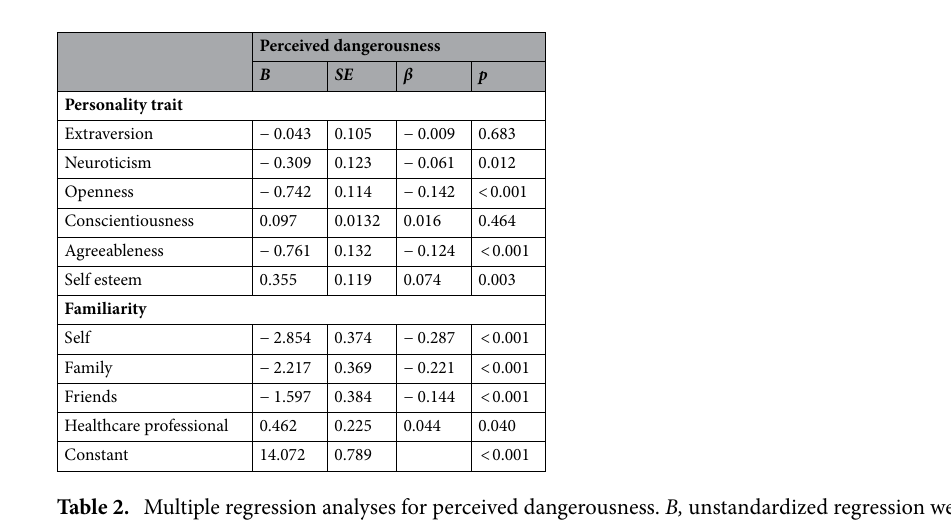
Perceived dangerousness. There linear regression analyses did not reveal significant bivariate associa- tions between age, gender, and education level with perceived dangerousness. The total model containing all predictors was significant ( N = 2065, F (10, 2055) = 19.87, p < 0.001). It explained 8.4% (adjusted R square) of the variance in perceived dangerousness. The multiple regression analysis revealed negative associations between openness to experience ( β = − 0.14, p < 0.001), agreeableness ( β = − 0.12, p < 0.001), neuroticism ( β = − 0.06, p = 0.012), and perceived dangerous- ness, which indicates that people with higher scores in openness to experience, agreeableness, and neuroticism reported lower perceived dangerousness. Neither conscientiousness nor extraversion were significantly linked to perceived dangerousness. On the contrary, there was a positive relationship between self-esteem (β = 0.07,